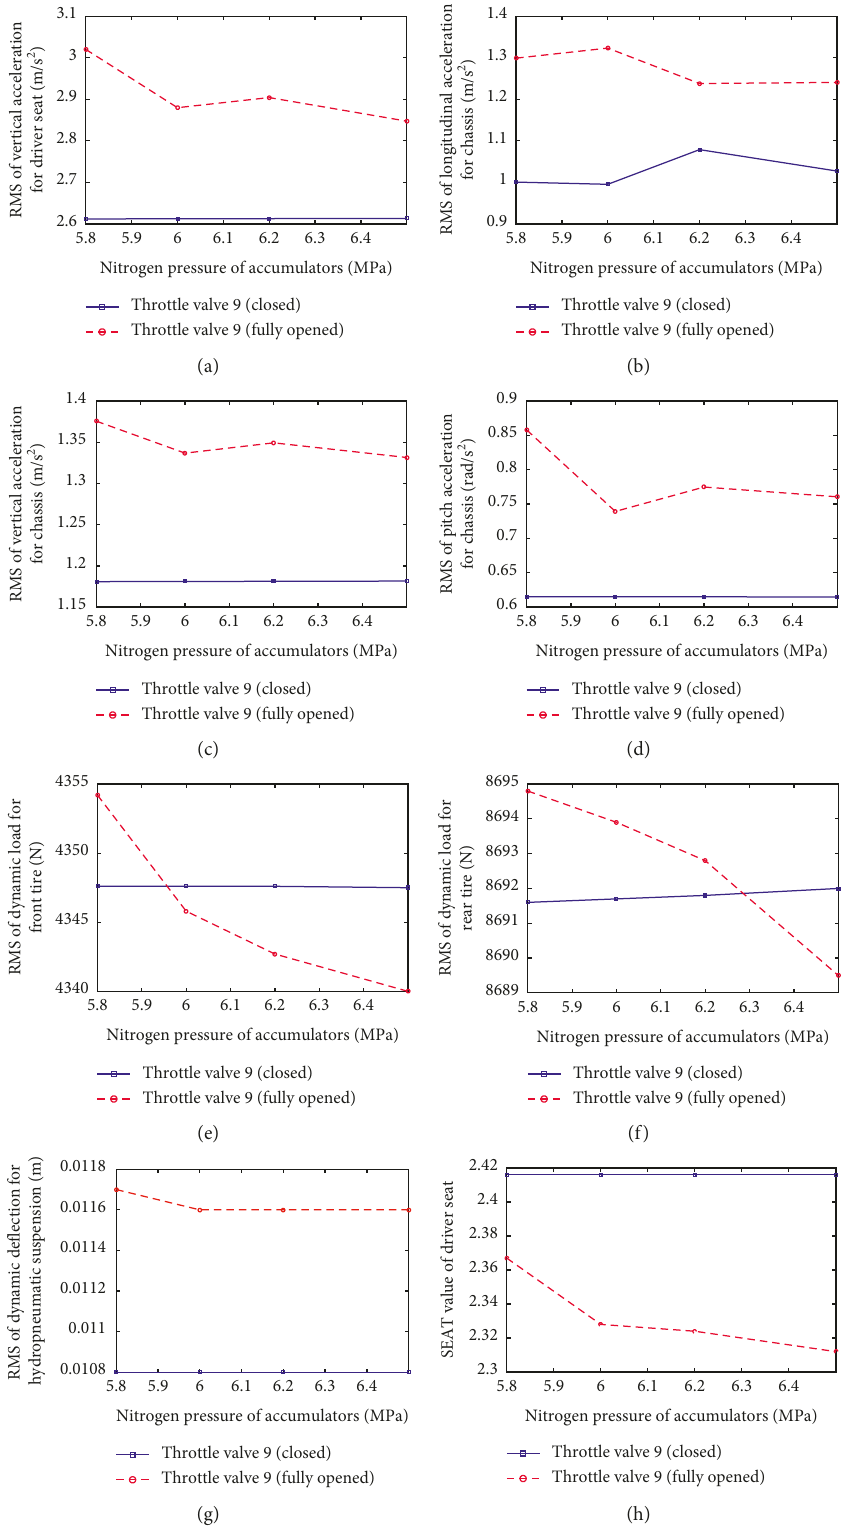
Figure 14: RMS of vibration responses of tractor system under different nitrogen pressure of the accumulators: (a) vertical acceleration of the driver seat; (b) longitudinal acceleration of the chassis; (c) vertical acceleration of the chassis; (d) pitch acceleration of the chassis; (e) dynamic load of the front tire; (f) dynamic load of the rear tire; (g) dynamic deflection of the hydropneumatic suspension; (h) SEATvalue of the driver